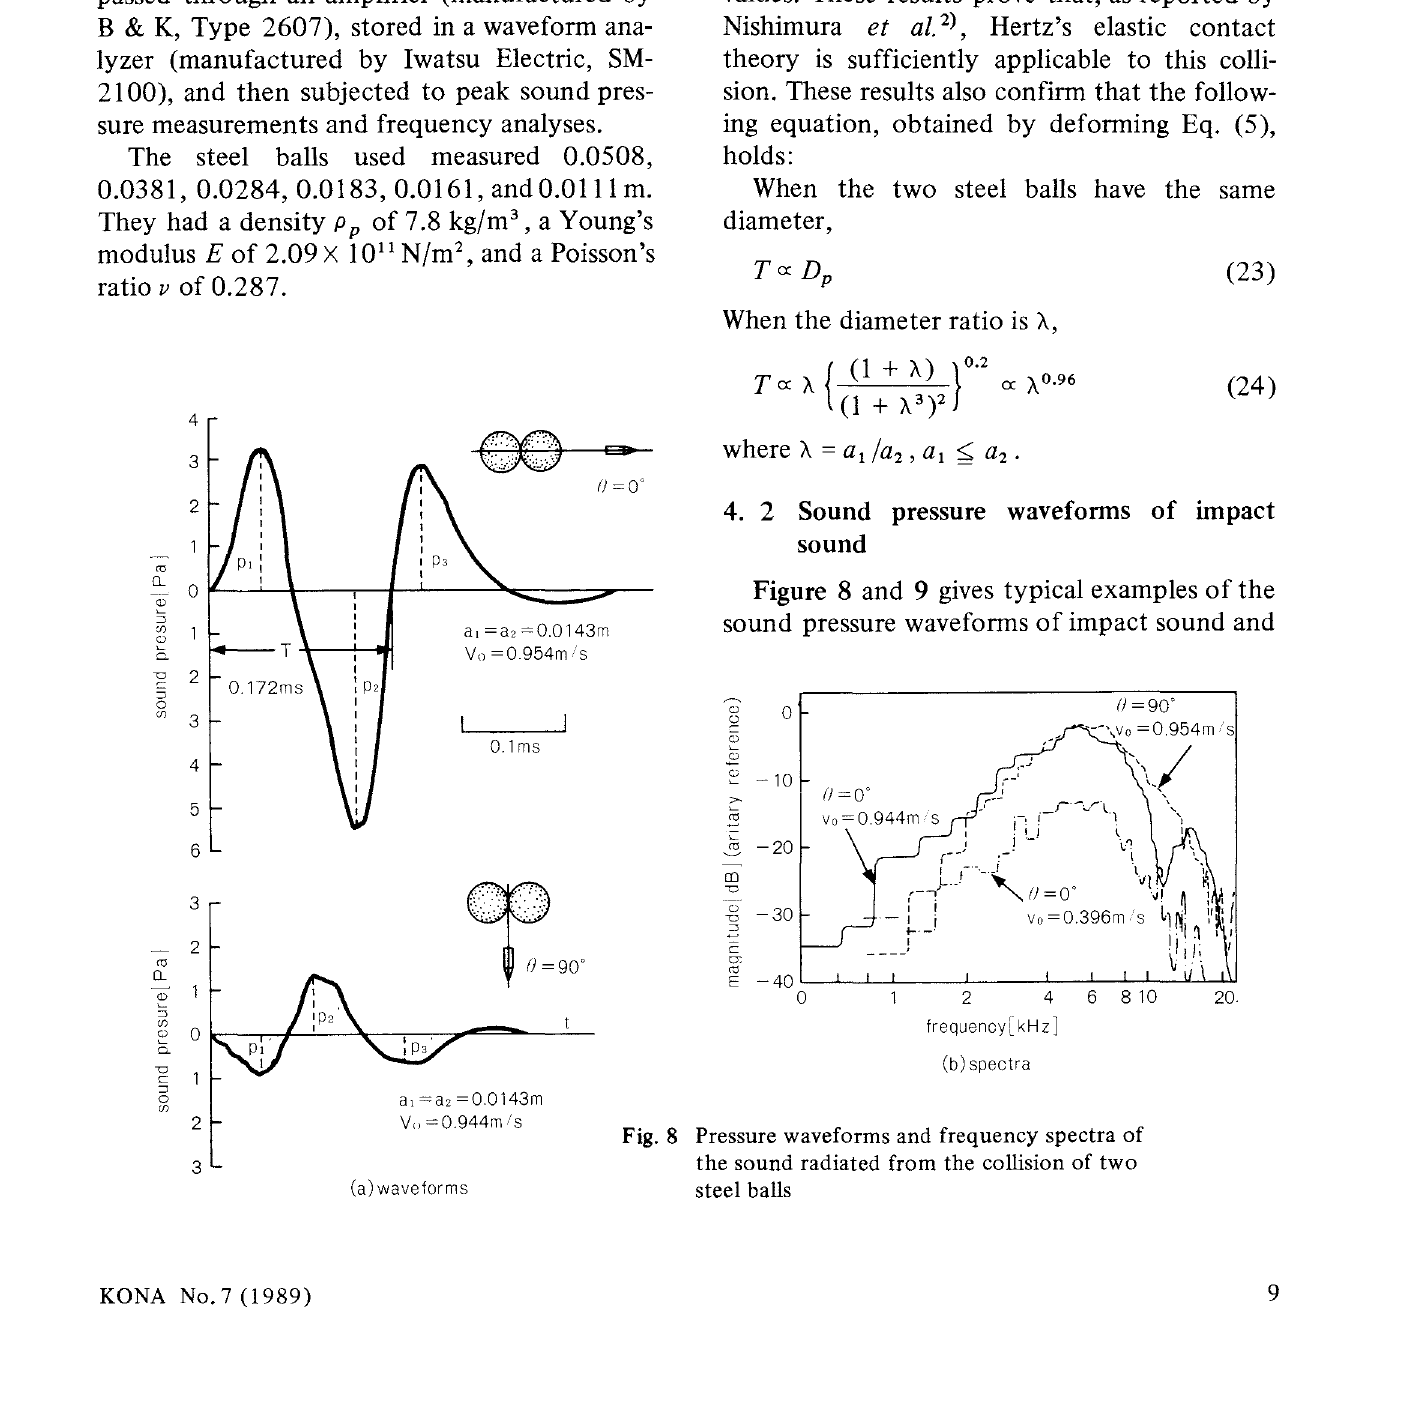
Fig. 8 Pressure waveforms and frequency spectra of the sound radiated from the collision of two steel